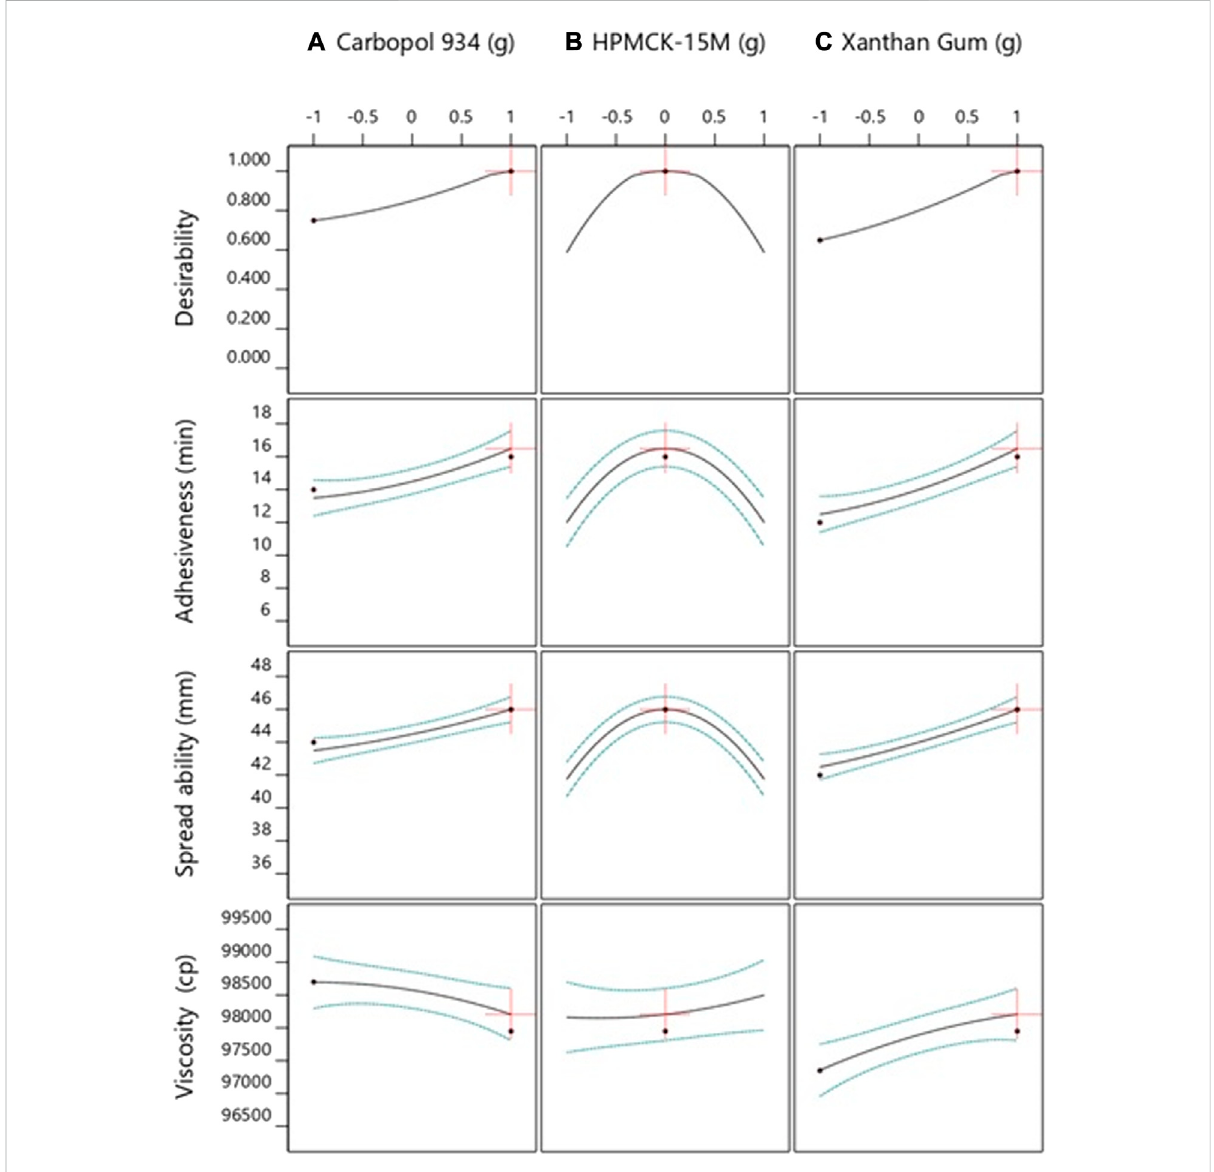
Table 2 provides the values for the tested formulations. The reference formulation ’ s average viscosity using L4 and R3 spindle was noted at 98,534.91 and 1,290.41 cP, respectively, and the average torque was 0.56 and 0.46,